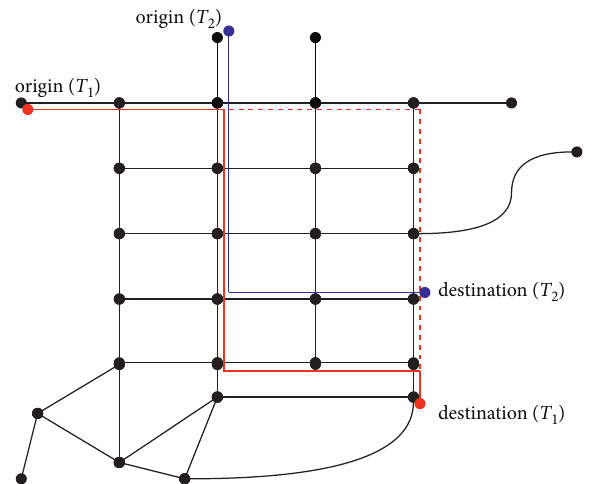
Figure 1: Illustration of Algorithm 1. The red and blue paths are the shortest-duration paths in iteration I � 1; in the next iteration, the red path changes to the dashed line in response to the reduced traffic speeds along the old